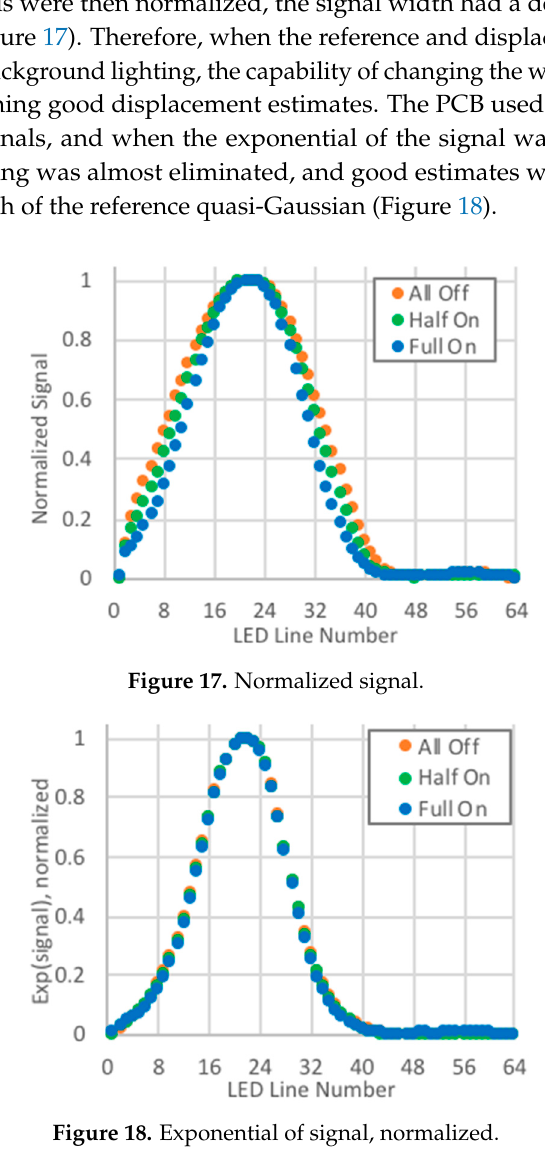
Figure 18. Exponential of signal, normalized.